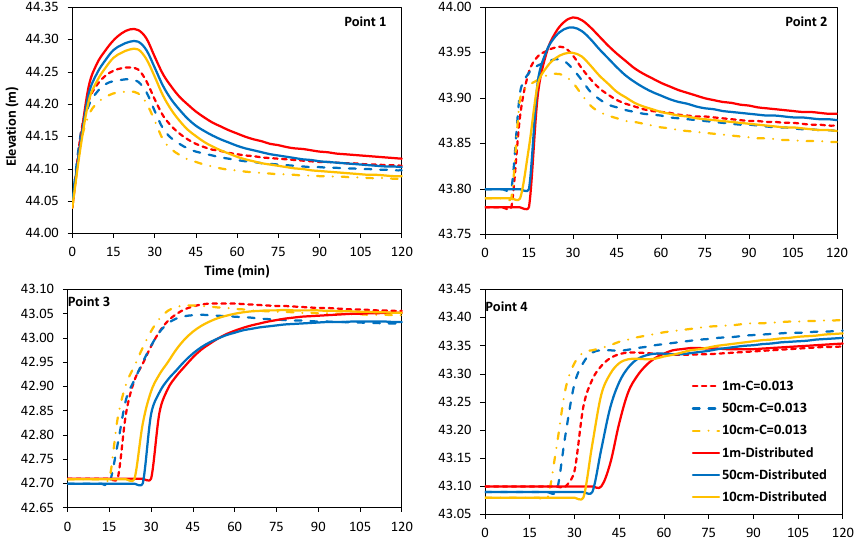
Fig. 9. Profiles of simulated water elevation through time at the four control points at 1x =10cm, 50cm and 1m using Composite ( C ) and Distributed roughness